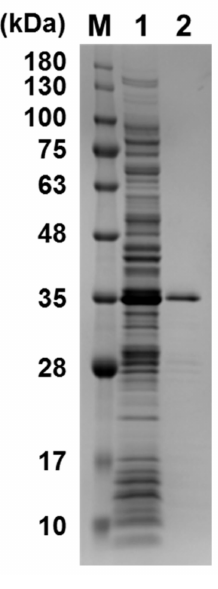
Figure 2. SDS-PAGE of purified GST-SP1 (37.5 kDa). M: protein marker; 1: crude fraction; 2: purified GST-SP1.